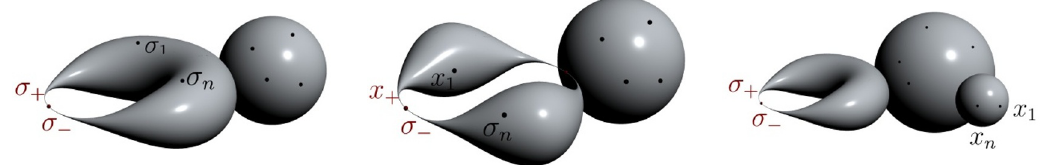
Figure 11 . The singular worldsheet con(cid:12)gurations that give a dominant balance in the limit as z ! 1 . For each of them, the integrand scales as I (1)